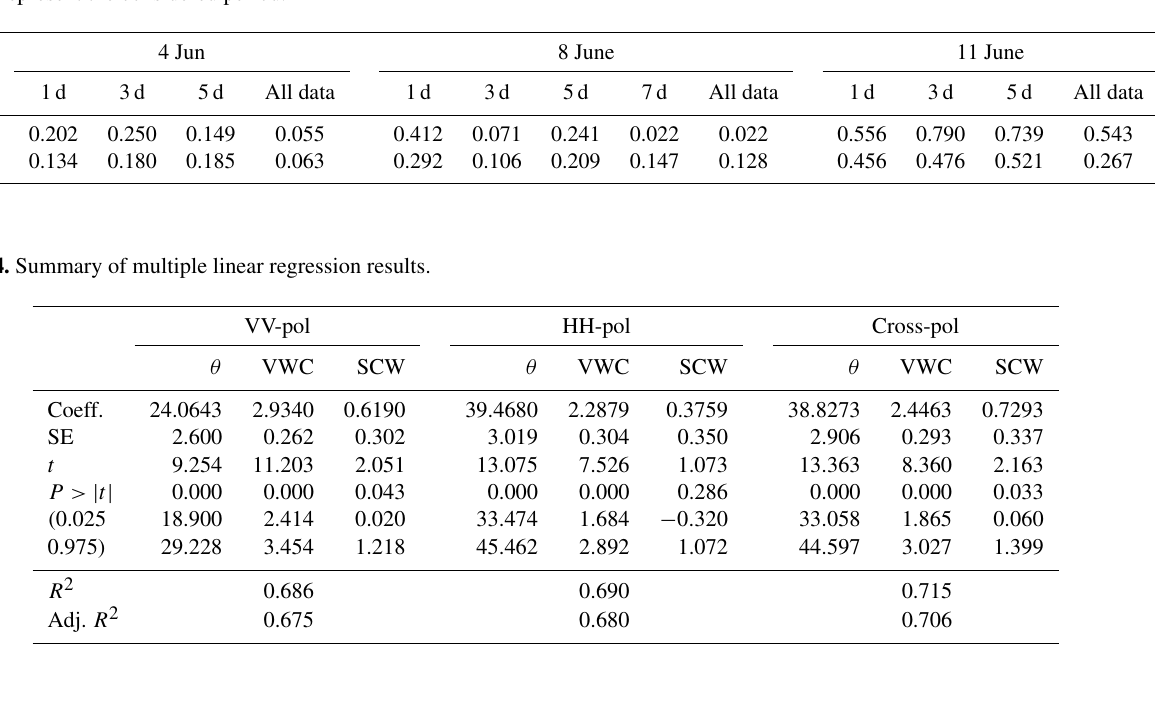
Table A3. Offset between reconstructed and sampled VWC. The rows represent the method used for transpiration estimation, while the columns represent the considered period.